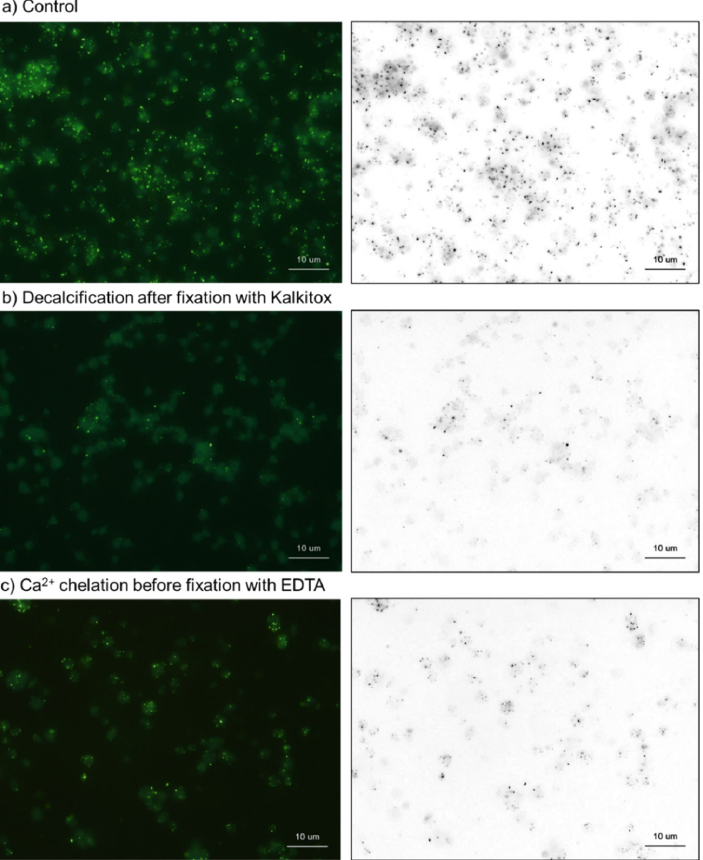
Figure 7. The effects of Kalkitox and EDTA on platelet polyP (green and black microparticles in left and right columns, respectively). Fixed platelets were treated with Kalkitox or 5 mM EDTA for 30 min ( b ). The control was incubated in Milli-Q water without decalcification reagents ( a ). Bar = 10 µ m. Similar results were observed in four other independent experiments.